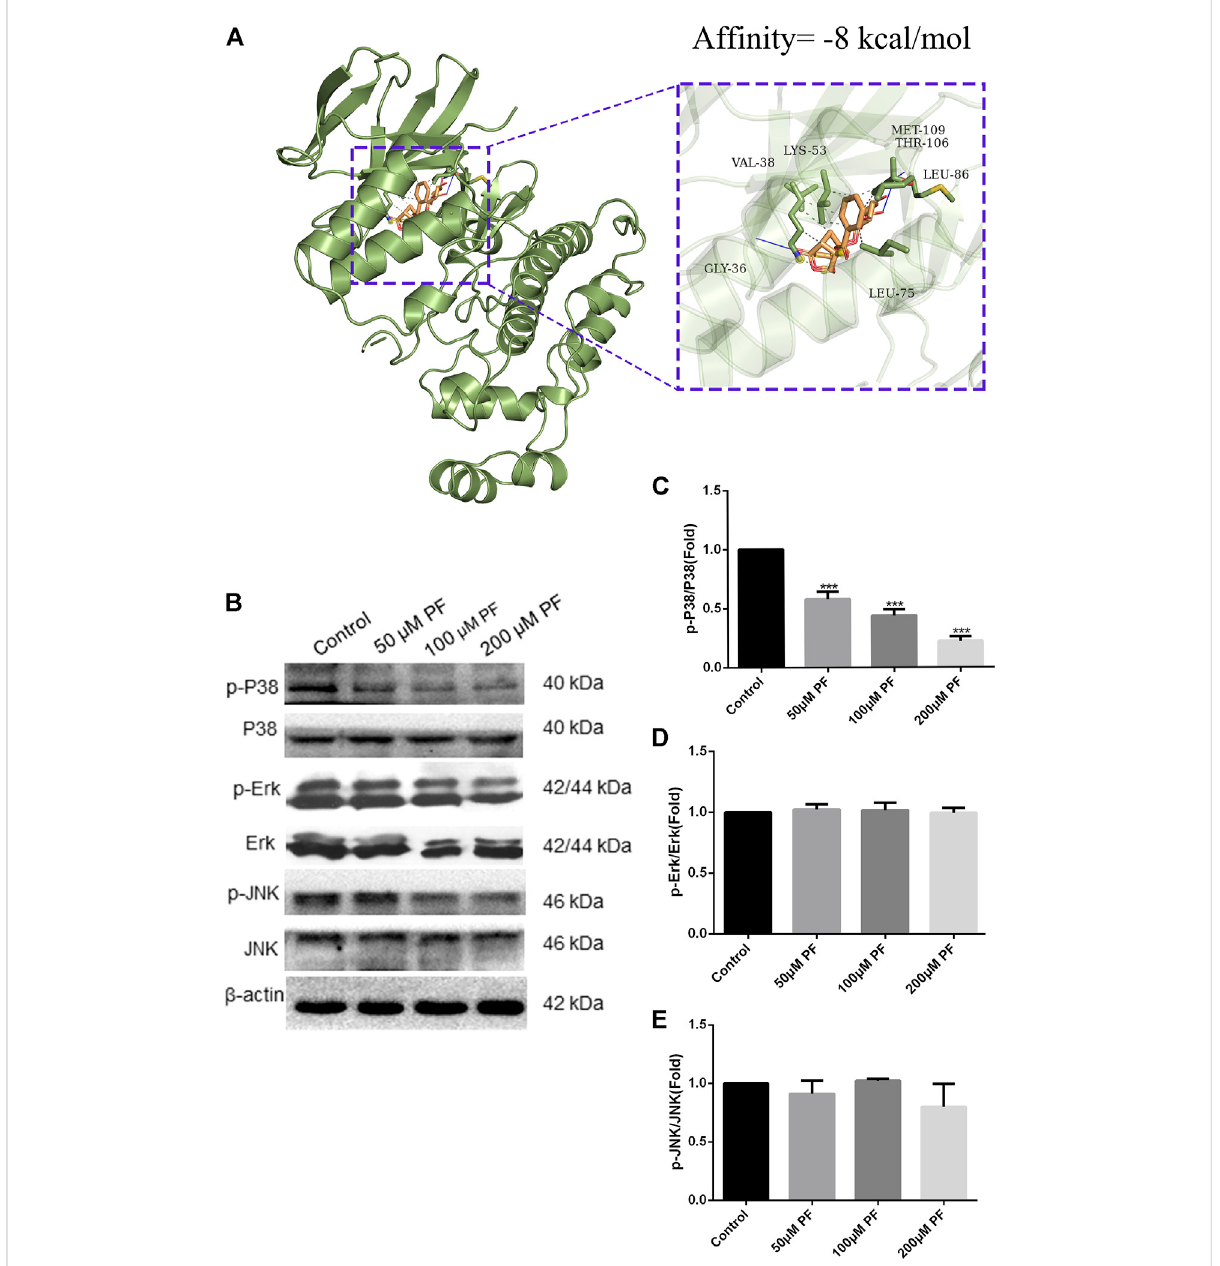
FIGURE 10 PFsuppressed MAPK signalpathway inPANC-1. (A) PFexhibitedgoodbindingactivitytop38asdeterminedbymolecular docking. (B) Basedon the results of Western blot analyses, PF was shown to decrease p38-related phosphorylation in MAPK signaling. This image displays some typical consequences from WB banding. (C – E) Each protein ’ s relative expression level was measured using statistical methods: p-ERK, p-JNK, and p-P38. *** p < 0.001 vs. control